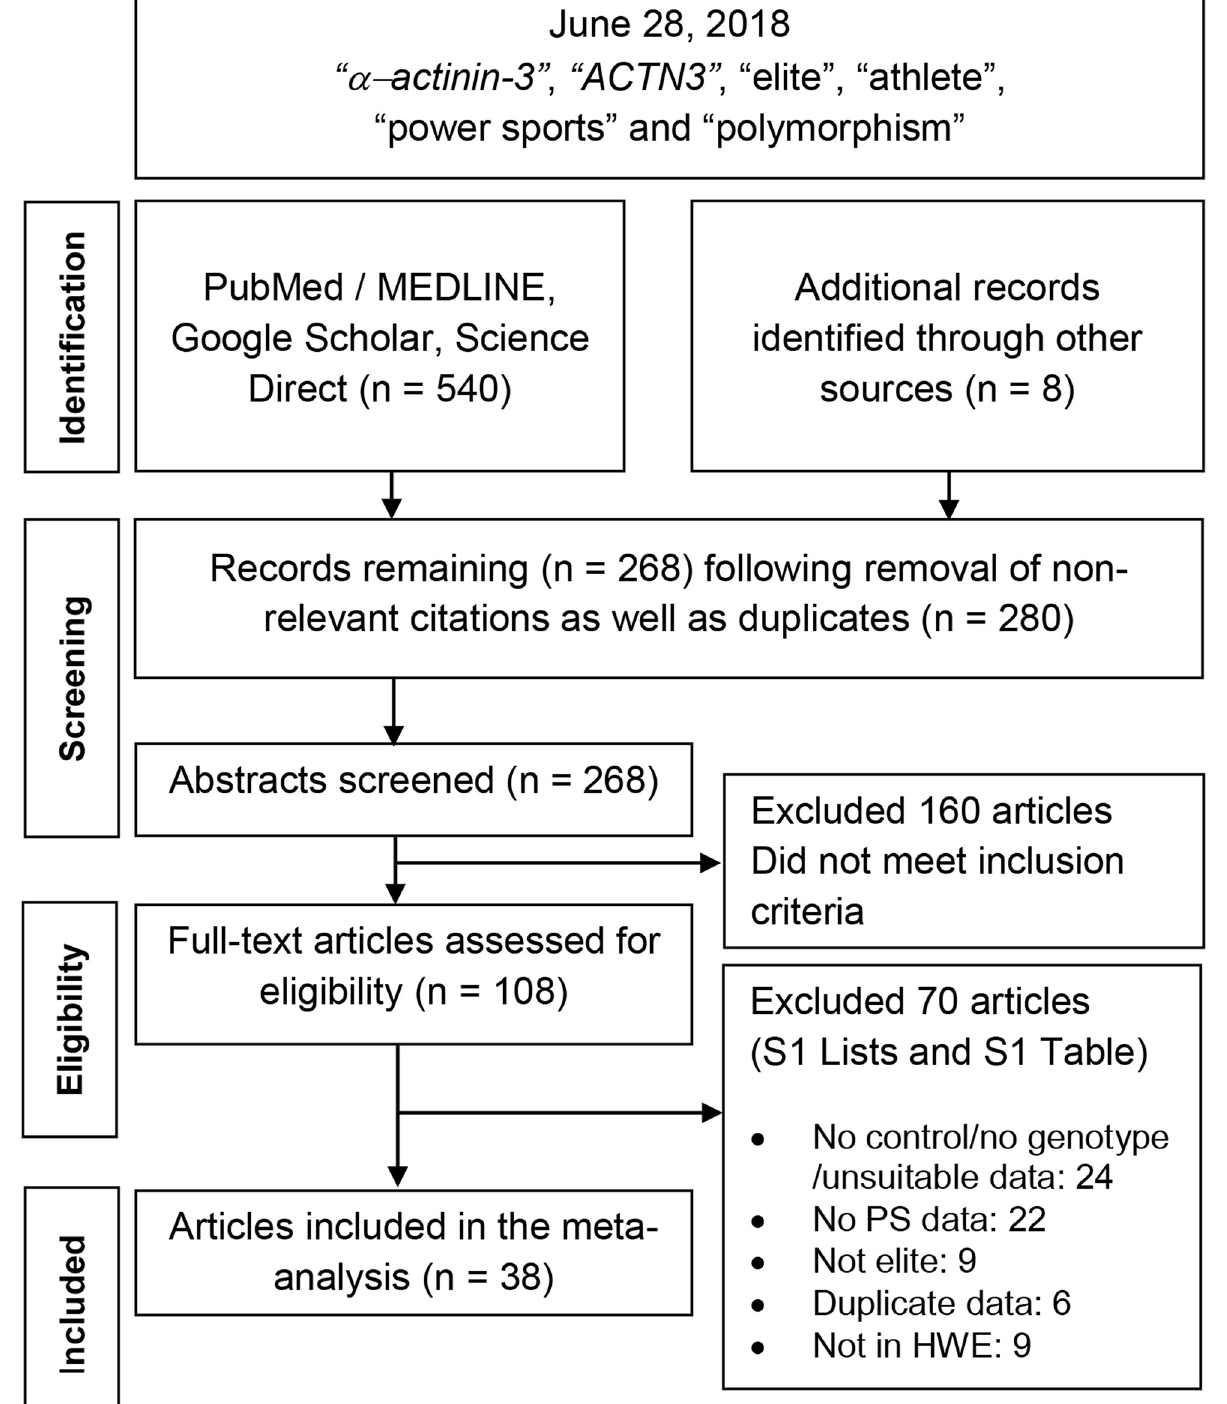
Fig 1. Summary flow chart of literature search. ACTN3 : alpha-actinin-3 ; HWE: Hardy-Weinberg Equilibrium; PS: power sports.